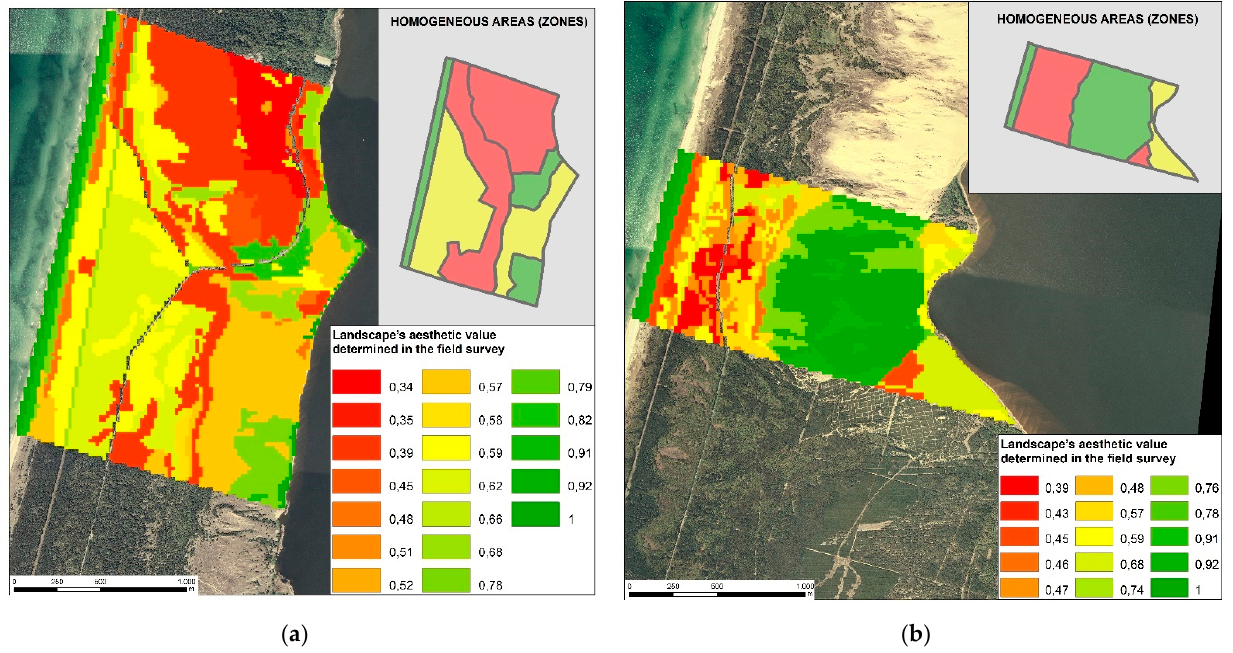
Figure 11. Zoning of Nagliai Strict Reserve and its buffer zone on the basis of computed values of scenic quality. Homo- geneous areas (zones) of low (red), medium (yellow) and high (green) scenic quality are distinguished, between which there are transitional value buffers: ( a ) Northern part of Nagliai Strict Reserve and its buffer zone; ( b ) Southern part of Nagliai Strict Reserve and its buffer zone. The mobile (white) dunes of Nagliai Strict Reserve, with restricted access, enjoy the highest values of scenic quality. (Drawn by Arvydas Urbis).